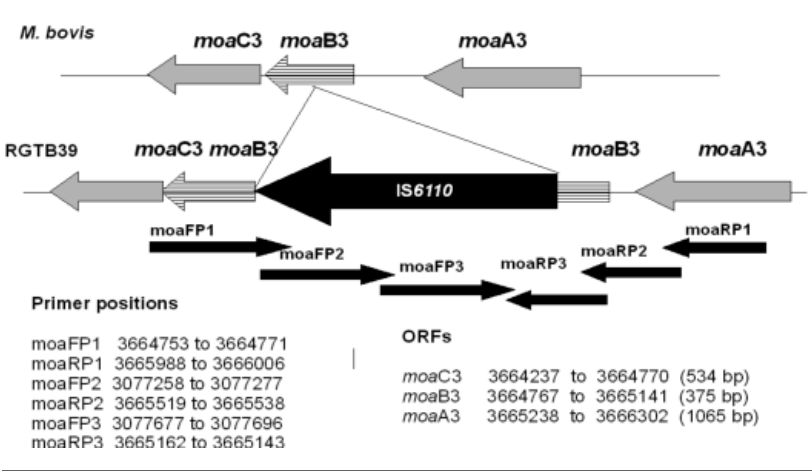
Figure 2. Schematic representation of the genome position of IS 6110 insertion in the moa B3 gene of RGTB39. The different sequences obtained to get the final assembly of the 2.6 kb PCR product are shown as striped arrows. The genome coordinates ( M. bovis ) of the primer positions and the genes are also